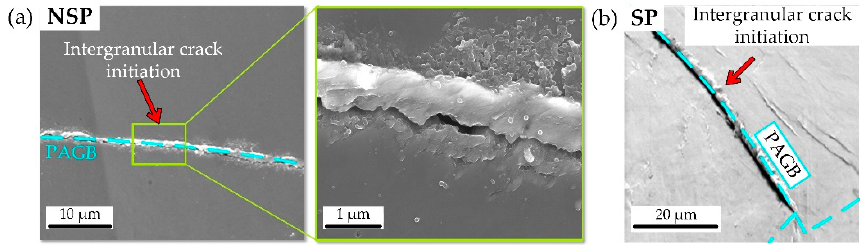
Figure 7. SEM images of intergranular crack initiation caused by the impingement of slip bands on a PAGB in an ( a ) NSP sample, loaded at ∆σ /2 = 600 MPa after 90,000 loading cycles, and an ( b ) SP sample, loaded at ∆σ /2 = 630 MPa after 300,000 loading cycles.